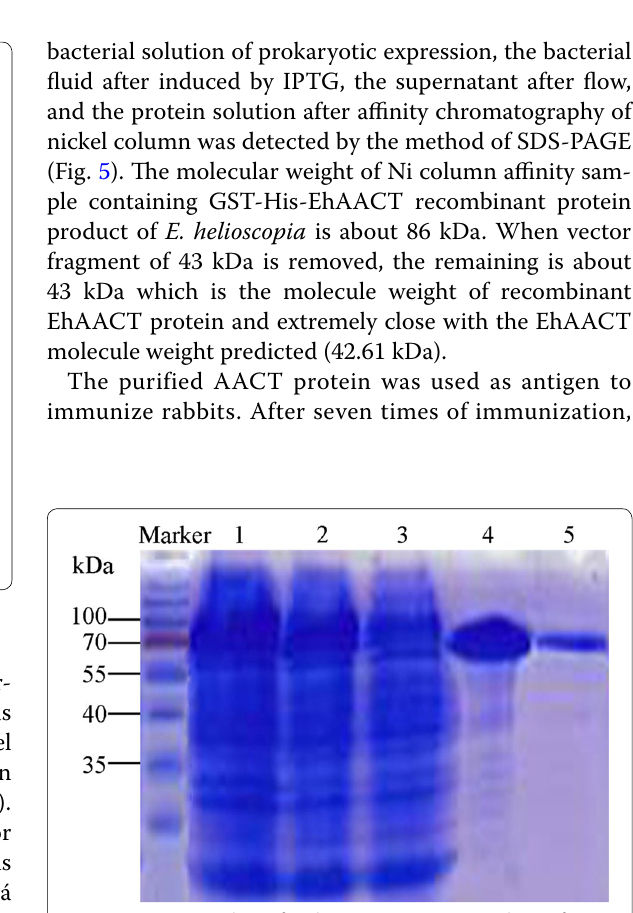
Fig. 5 SDS-PAGE analysis of prokaryotic expression products of EhAACT. Marker: Protein marker; 1: All the bacterial solution of prokaryotic expression; 2: Bacterial solution produced by IPTG induc- tion; 3: The supernatant of breaking bacterial cells; 4: Fusion protein produced by Ni-chelating affinity chromatography; 5: Protein solution diluted